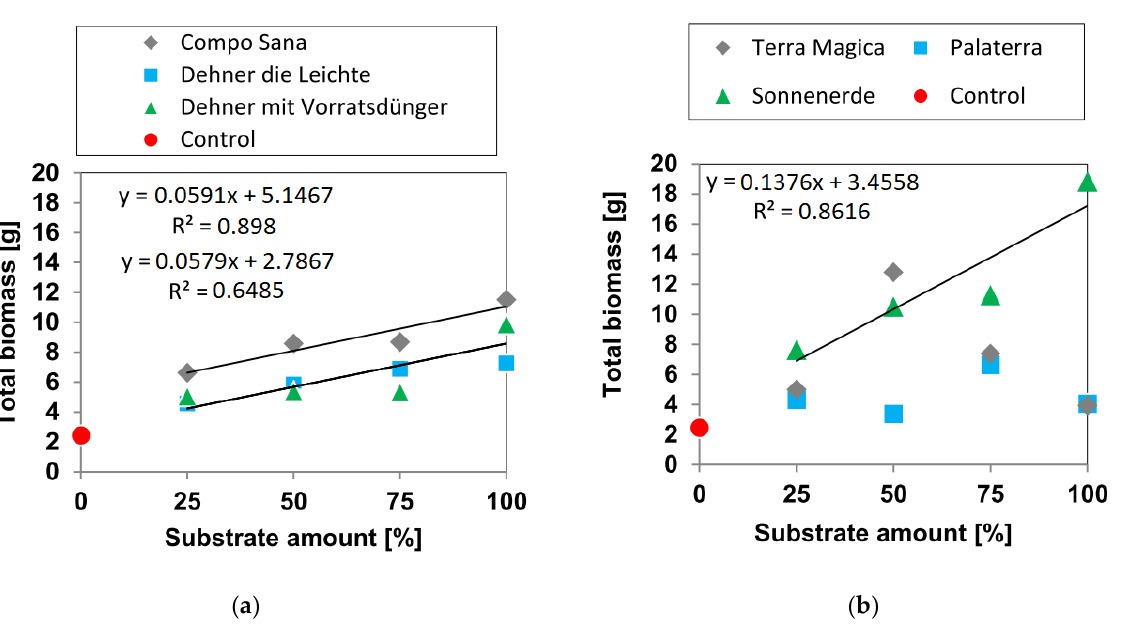
Figure 3. Maize yield per pot after 30 days in peat-based ( a ) and biochar-based ( b ) growing media mixed with sand in different amounts. In this Figure, 0% = control (pure sand) and 100% = pure growing media. Error bars represent standard error of the mean (n = 5). R 2 was calculated with the Spearman correlation coefficient.